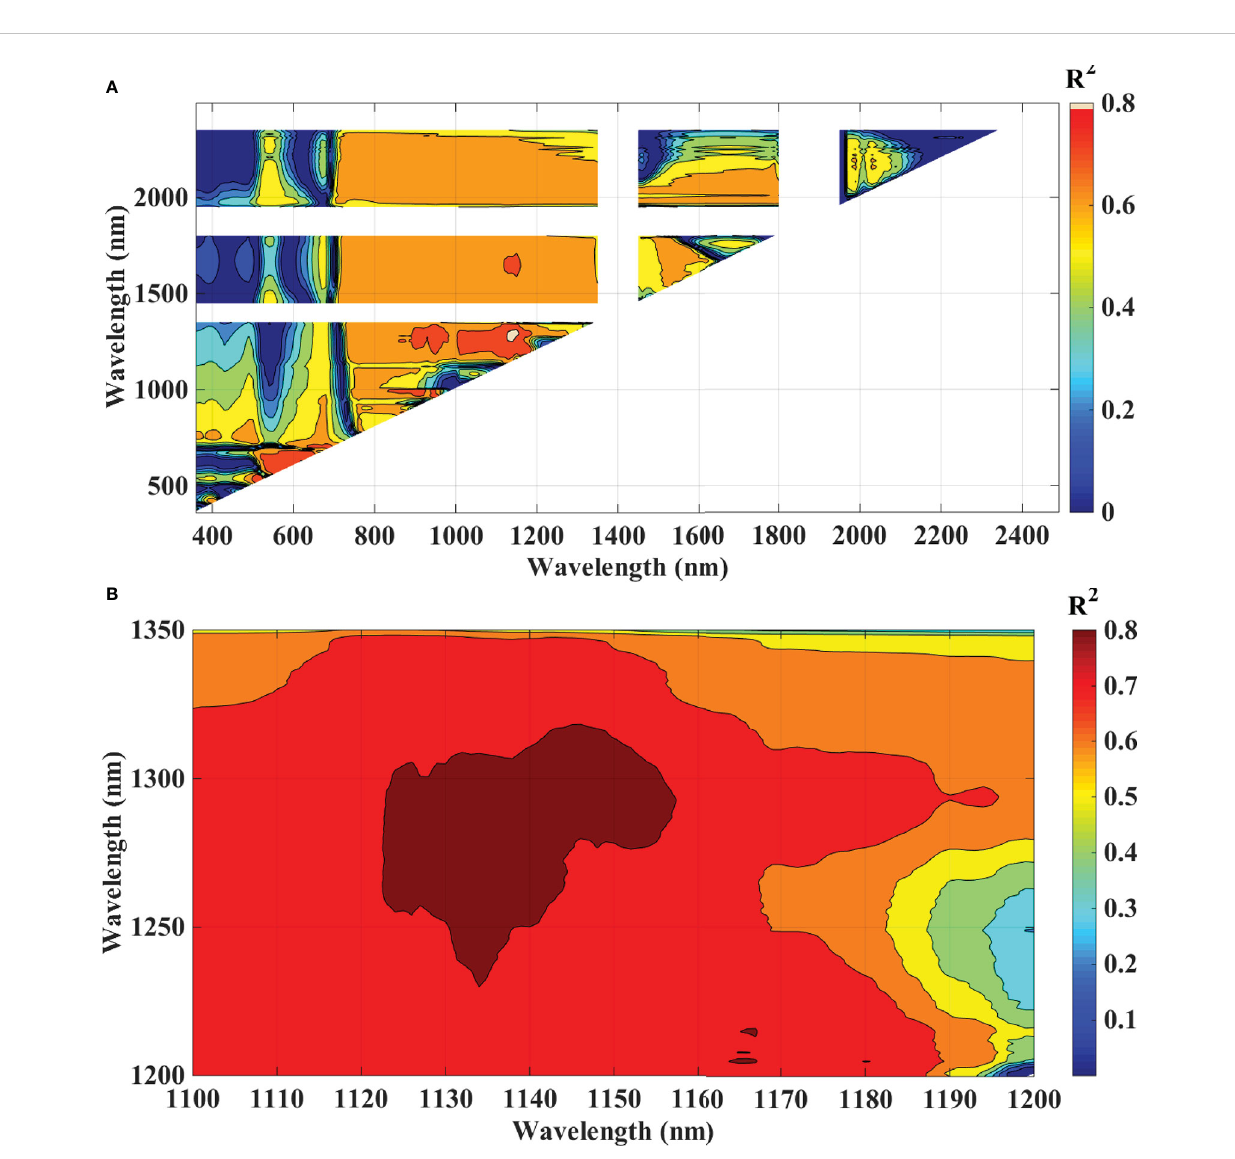
FIGURE 8 Contour maps of coef fi cients of determination (R 2 ) for linear relationship between blast indices (RBI) with disease scores, of rice canopy under different blast disease severity levels at (A) 10 nm sampling interval at 350-2500 nm and (B) 1 nm sampling